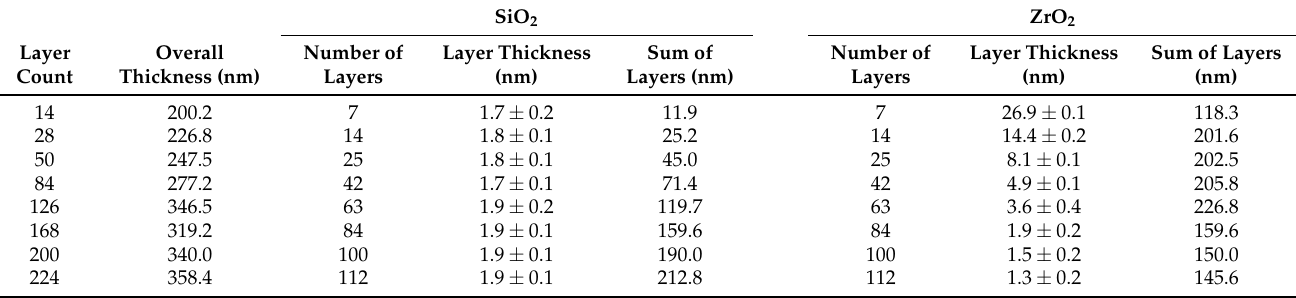
Table 1. Increasing numbers of thinner zirconia layers interleaved with fixed thickness silica designed to determine the crystallization temperature threshold for zirconia. The layer thicknesses for both zirconia and silica are average individual